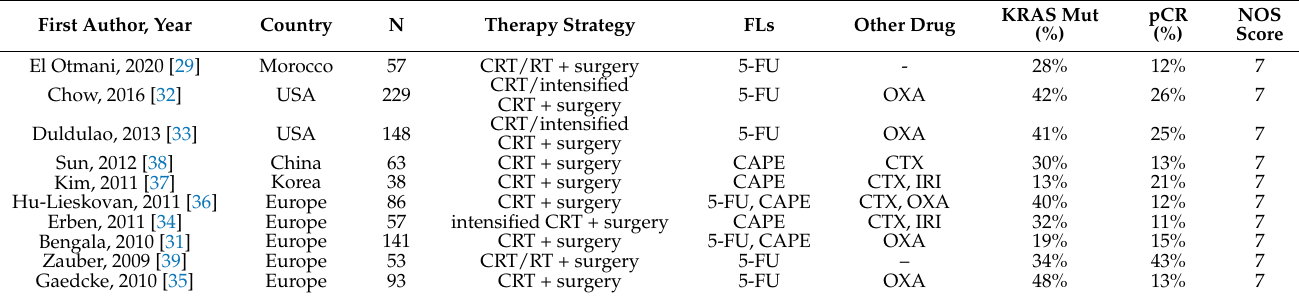
Table 1. Main characteristics of included studies for KRAS